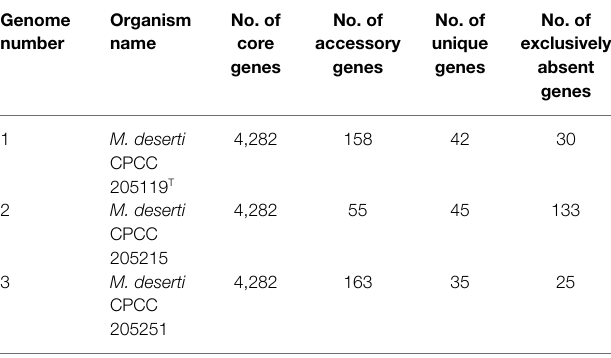
TABLE 2 | The pan-genome profile of the species Modestobacter deserti sp.